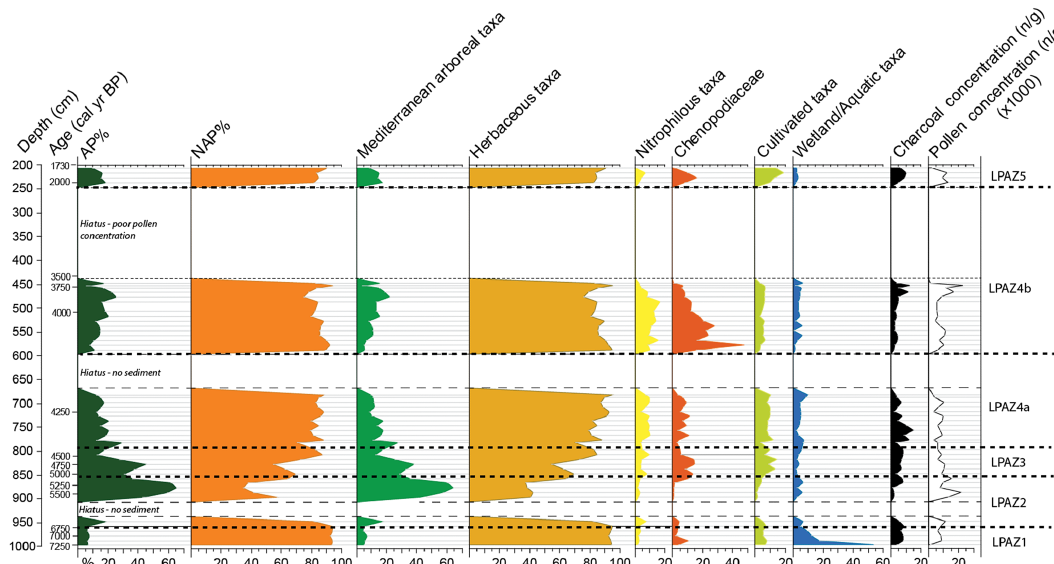
Figure 3. Burmarrad simplified pollen diagram: selected percentage curves and pollen concentration versus depth. Mediterranean arboreal taxa: Ephedra, Erica, Juniperus, Olea, Phillyrea, Pinus and Pistacia . Nitrophilous taxa: Rumex, Urtica and P. lanceolata-type . Cultiva- tion indicator taxa: including crops (Cerealia-type, Triticum- type) and some associated secondary indicator species (Brassicaceae, Con- volvulus) . The pollen percentages are calculated using the pollen sum of all terrestrial pollen counted; it excludes Cyperaceae and other aquatic/hygrophilous species, NPPs (non-pollen palynomorphs), and undetermined/indeterminable grains. The microcharcoal concentration was calculated using the sample weight and number of Lycopodium spores observed (following Stockmarr,